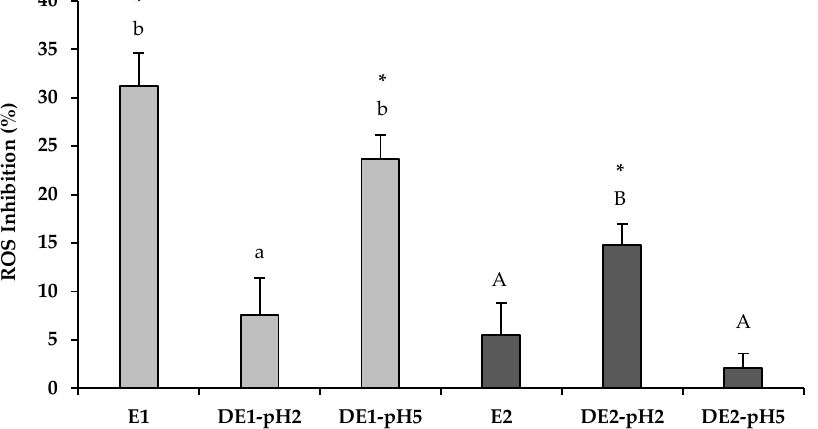
Figure 3. Inhibition effect of olive leaf extracts (E1 and E2) and their gastric digests at pH 2 and pH 5 (2 mg/mL) on intracellular reactive oxygen species (ROS) production by human gastric epithelial AGS cells after H. pylori infection. The experimental control (AGS cell without extracts) had 0% of ROS inhibition (data not showed). Values are the mean ± SD (n = 3). Asterisk indicate significant differences compared to the control group (untreated infected AGS cells) by t -test ( p < 0.05). a,b,A,B Different letters indicate statistical difference within a same extract by ANOVA post hoc HSD Tukey test ( p < 0.05).